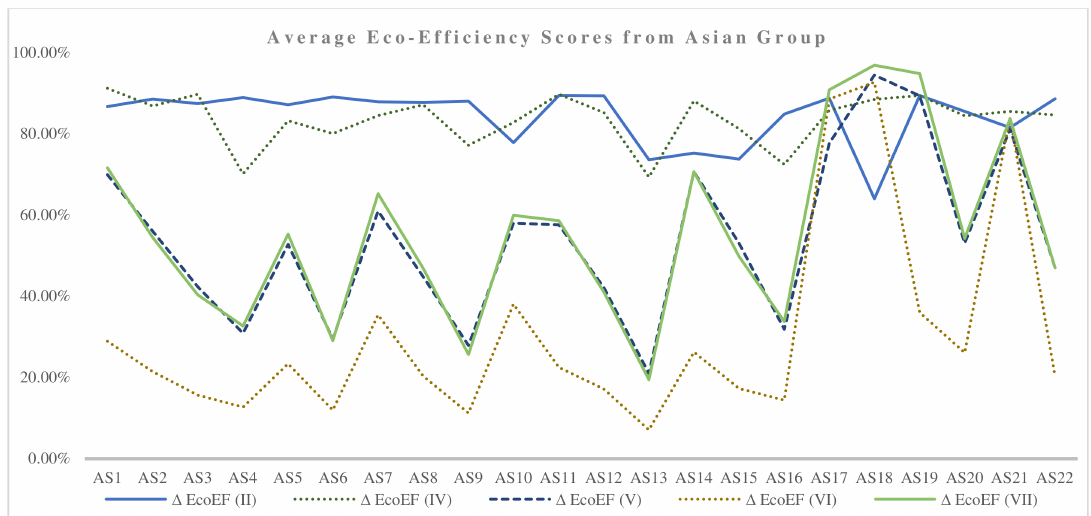
Figure 1. Eco-efficiency scores 2005–2018 for Asian economies. More details in Table A1 in Appendix A; 3 time-variant inefficient models (EcoEf (II), EcoEf (IV) and EcoEf (V)) and the two time-invariant inefficient models (EcoEf (VI) and EcoEf (VII)).